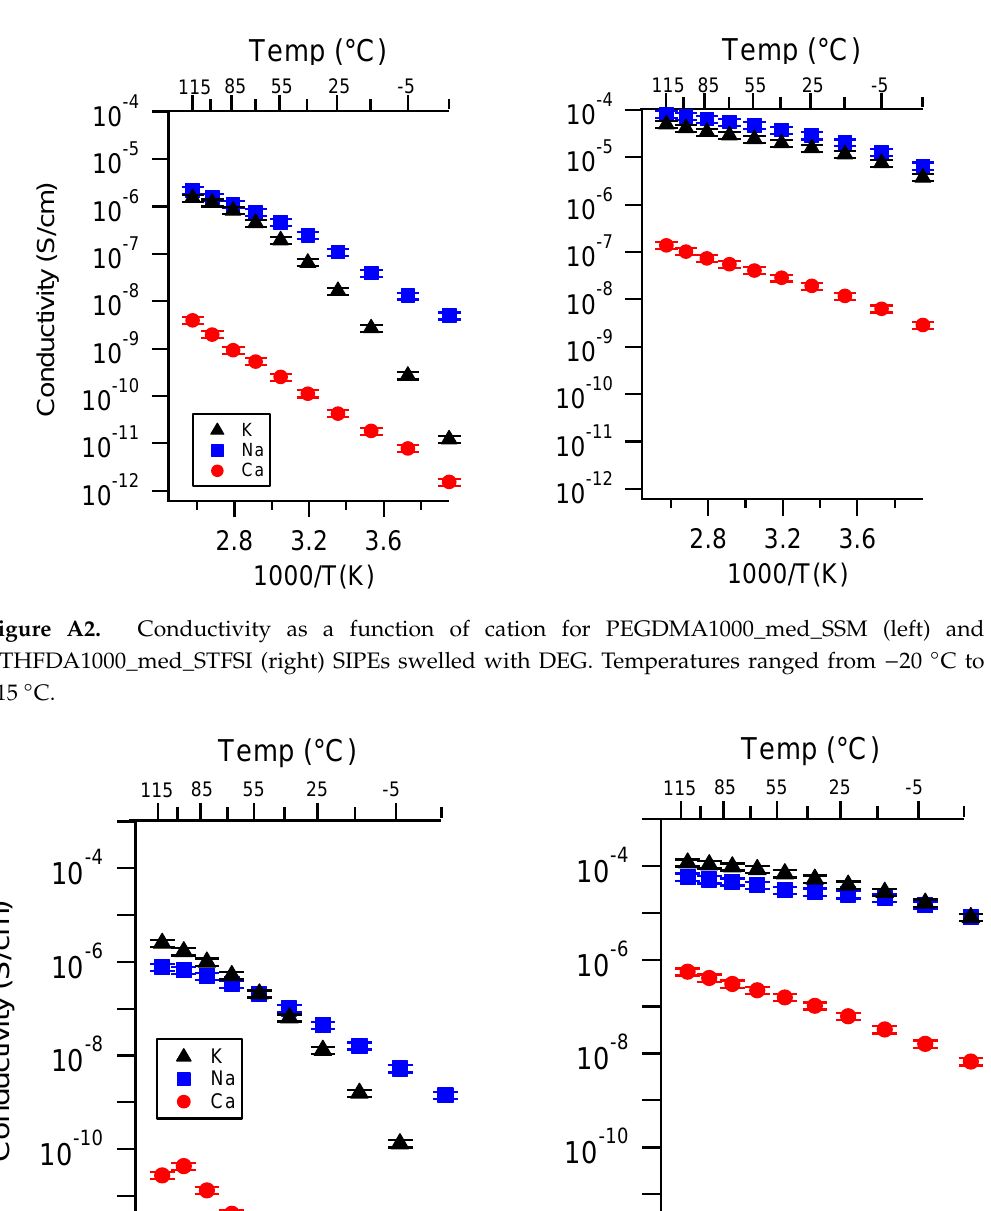
Figure A1. (reproduced from main text) Conductivity as a function of cation for PEGDMA1000_low_SSM (left) and PTHFDA1000_low_STFSI (right) SIPEs swelled with DEG. Temperatures ranged from − 20 °C to 115 °C.